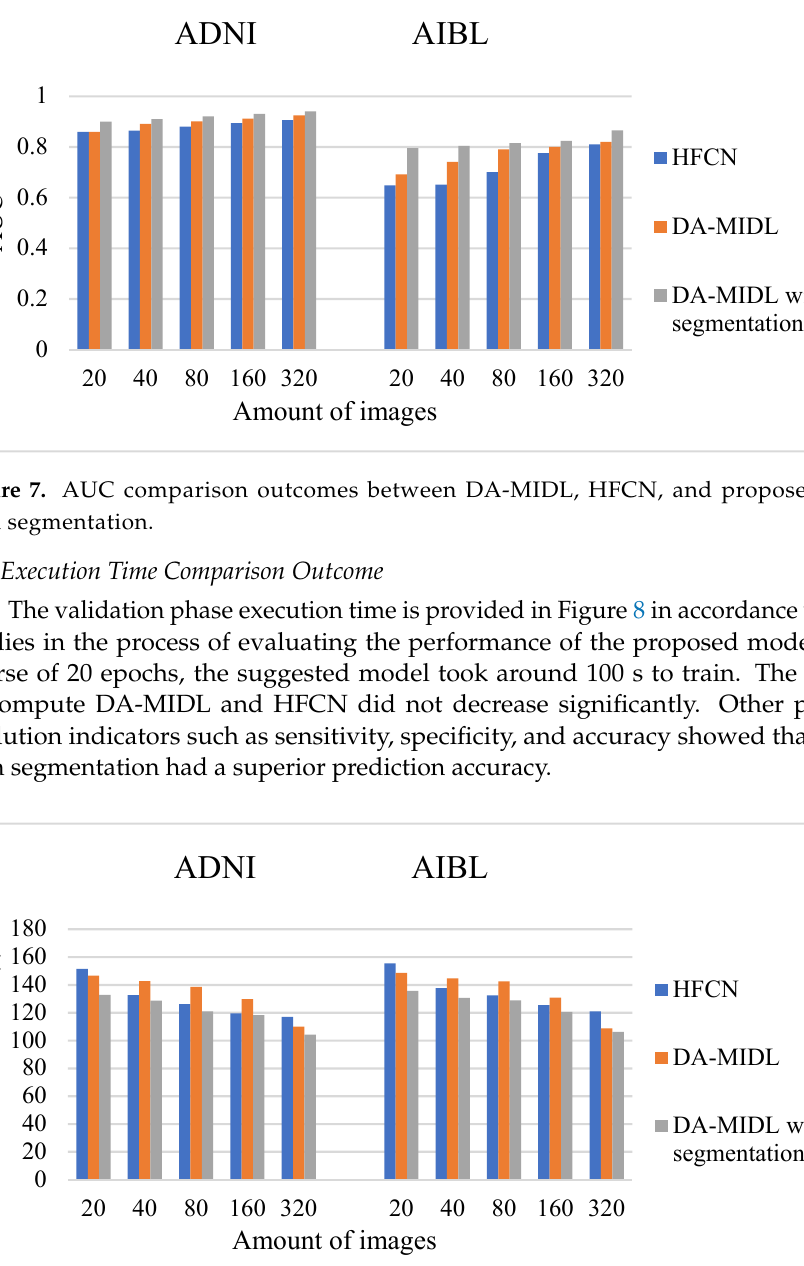
Figure 6. Specificity comparison outcomes between DA-MIDL, HFCN, and proposed DA-MIDL with segmentation.